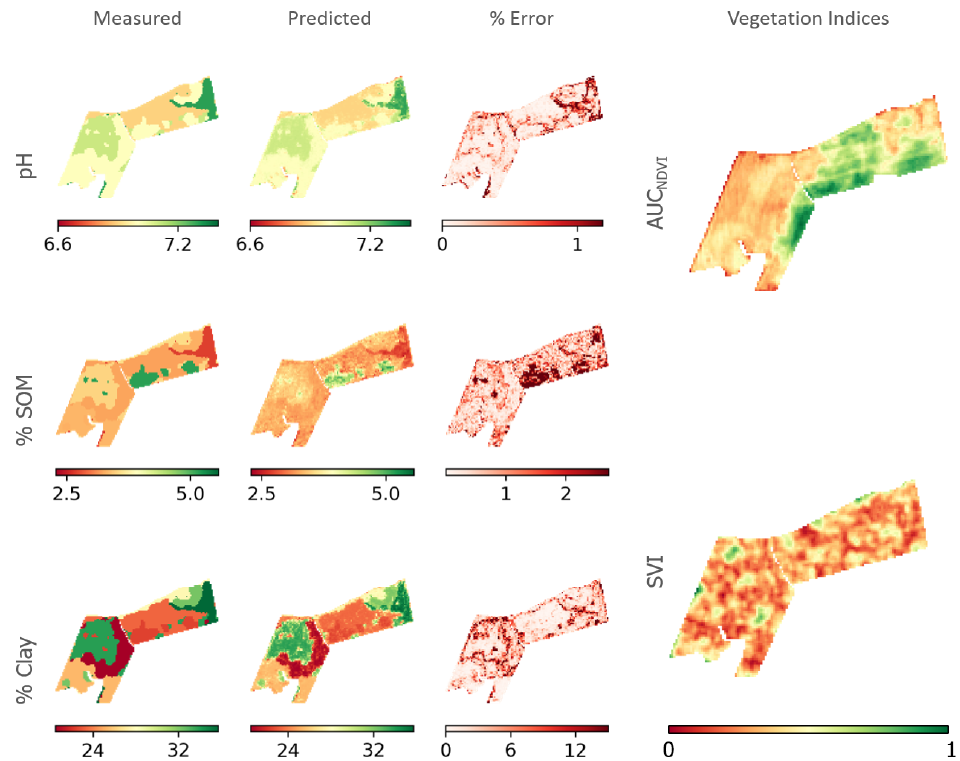
Figure 13. Predicted pH, SOM, and clay content for the Quellenacker field located in Germany. The columns represent zone averaged ground measurement, pixel-level model prediction, and percent error, respectively. Also, the area under the curve for NDVI and SVI are given for the cultivation period